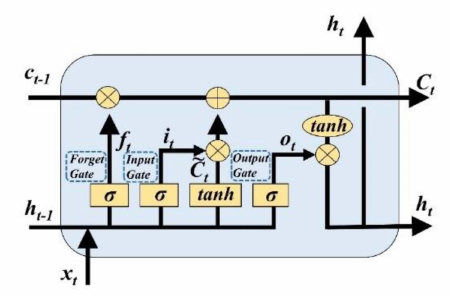
Figure 2. Long short-term memory (LSTM) module contains four interacting